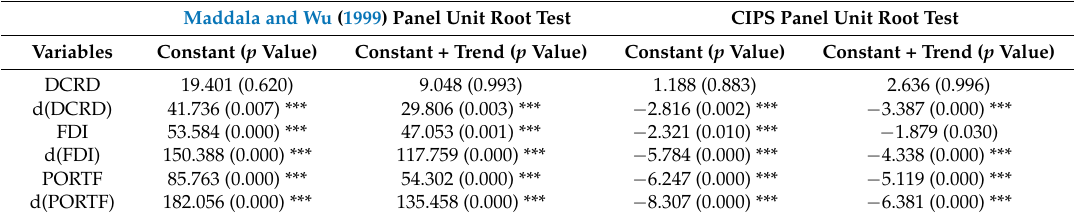
Table 4. Results of panel unit root tests.